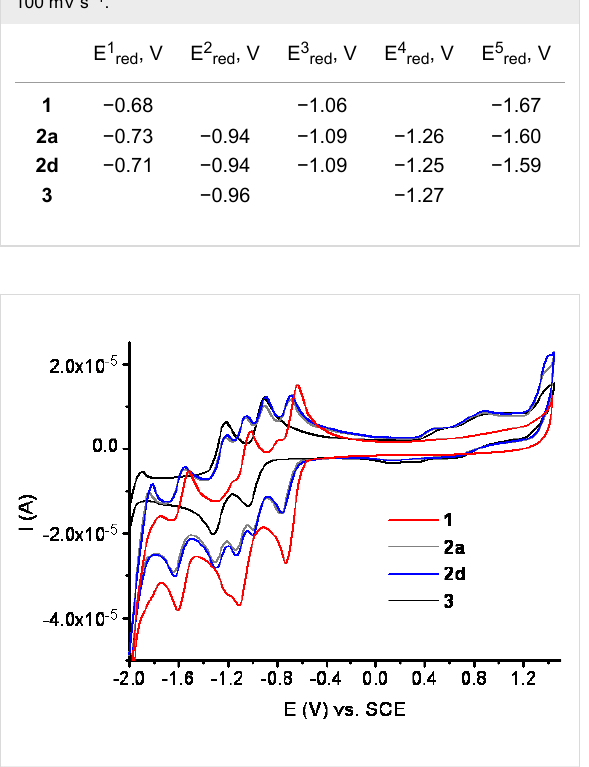
Table 1: Experimental values of reduction potentials E i red = (Ep i c + Ep i a )/2 of 1 , 2a,d and 3, vs. SCE, in CH 2 Cl 2 ( c = 10 −4 M), scan rate 100 mV s −1 .